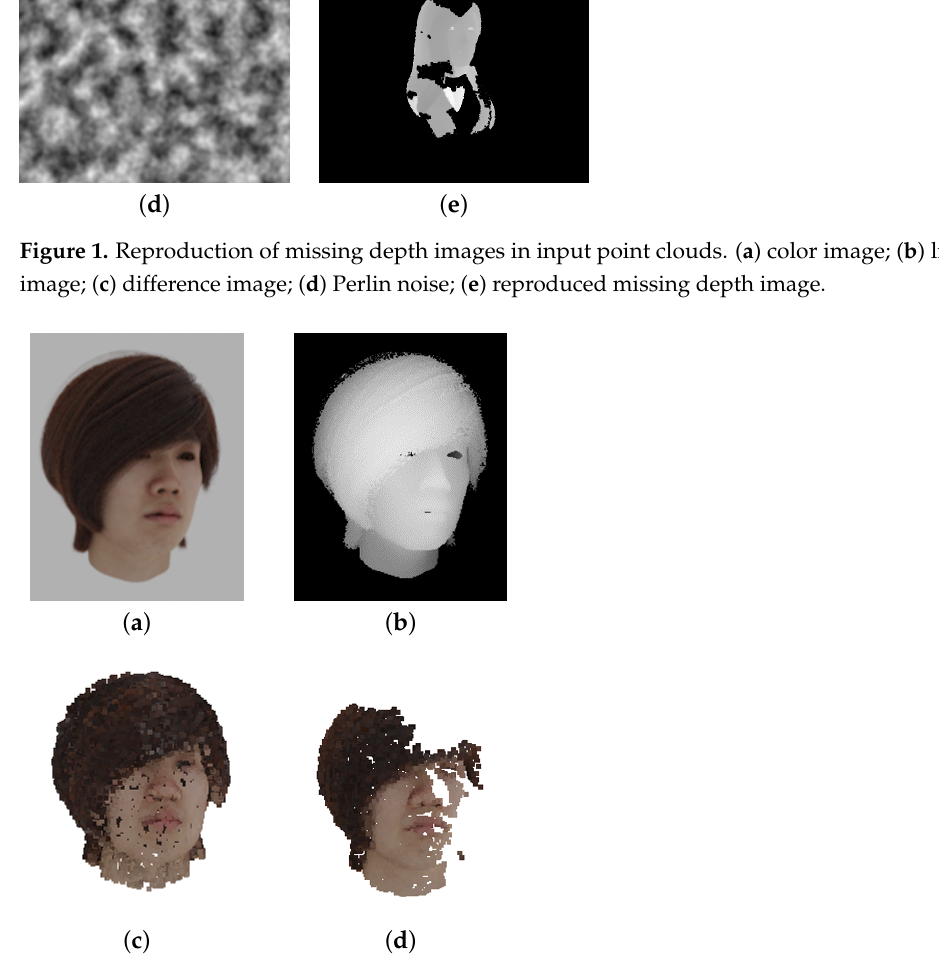
Figure 2. An example of a colored point cloud data set of the head. ( a ) color image; ( b ) depth image; ( c ) ground truth point cloud; ( d ) partial input point